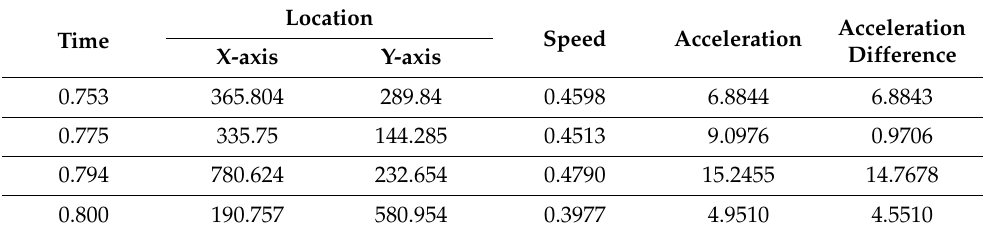
Table 3. Datasheet showing some randomly chosen data points from simulation data.